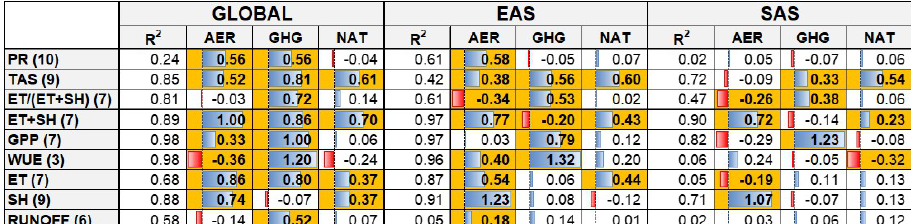
Figure 9. All parameters obtained in the MLRM analysis. The variable names are followed by the number of ensemble models in parentheses. Orange shading indicates statistical